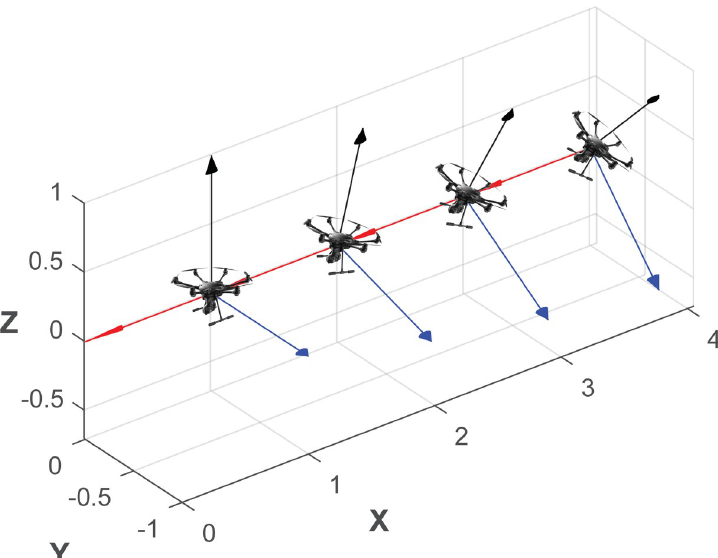
Fig 12. Polarization vector evolution at receiving antenna when a UAV is rolling (rotating with respect to the x axis).